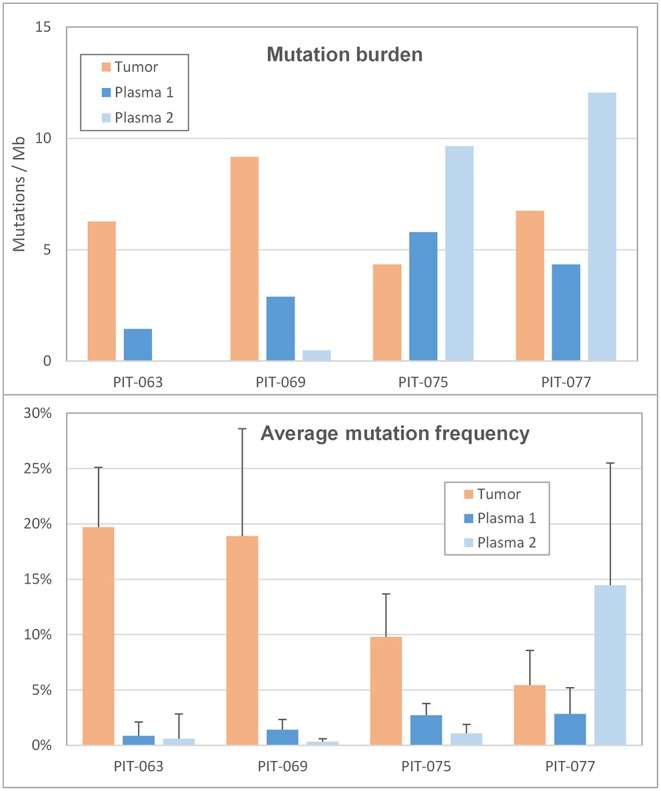
Mutation profile (Top) mutation burden in the tumor and in the two plasma samples, expressed as the number of miscoding mutations per megabase. (Bottom) Average frequency of the alternate allele in the tumor and in the two plasma samples. Error bars are the standard deviation.